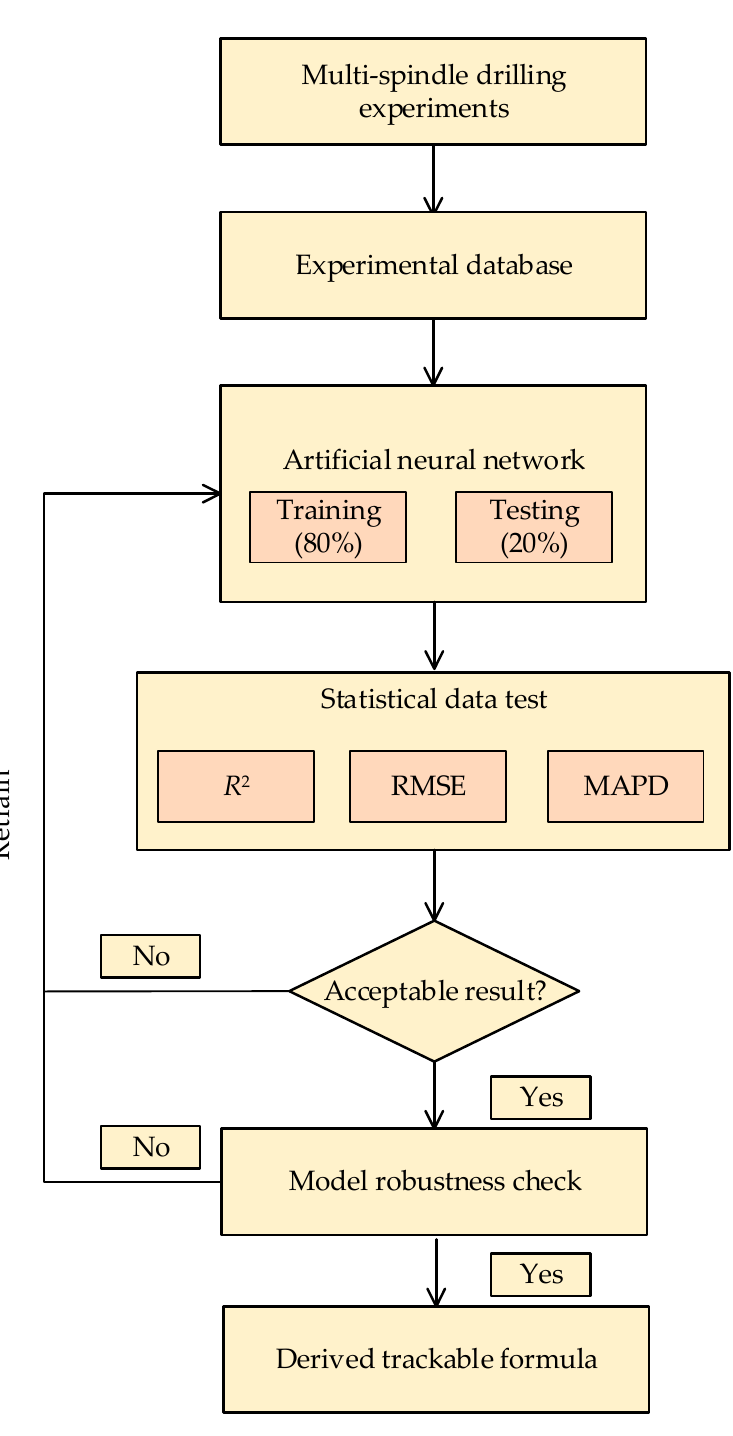
Figure 7. Proposed scheme for predicting the surface roughness.